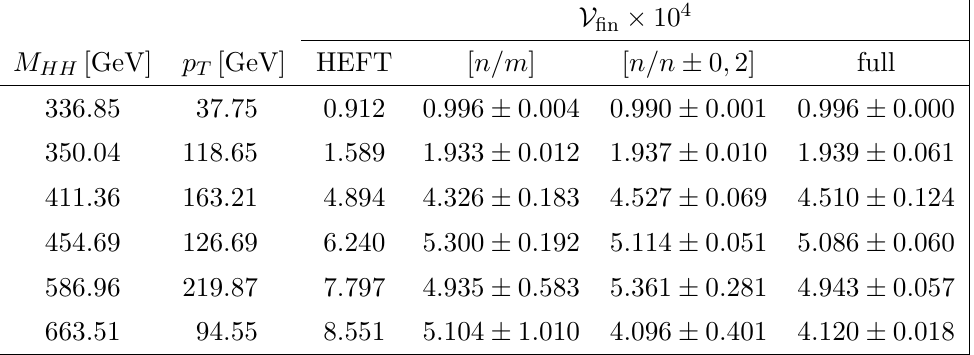
Table 2 . Numbers for the virtual corrections for some representative phase space points for the HEFT result reweighted with the full Born cross section (as in ref. [81]), the Pad(cid:19)e-approximated ones and the full calculation